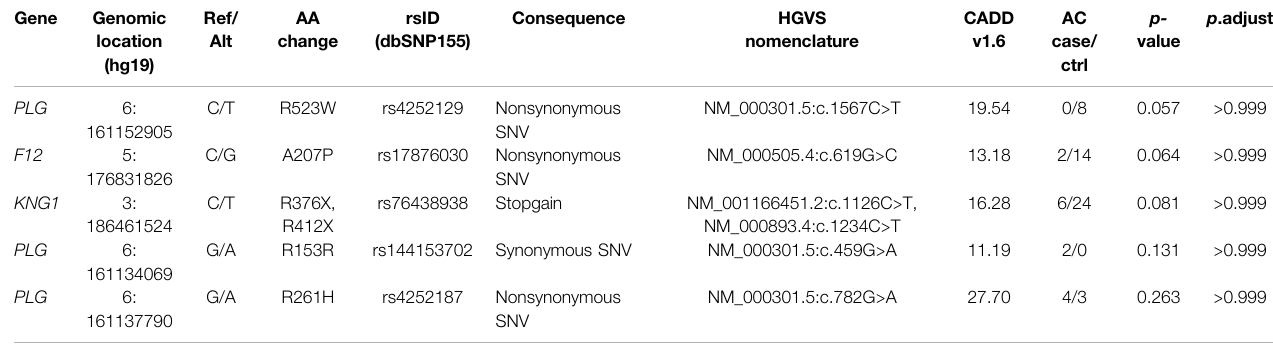
TABLE 2 | Top fi ve rare candidate variants identi fi ed via re-sequencing.